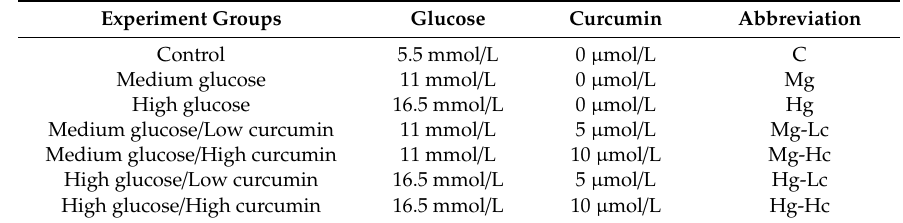
Table 1. Experiment groups and